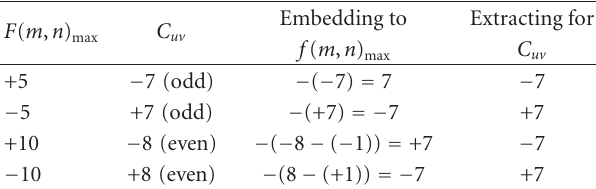
and C uv with the di ff erent sign. max